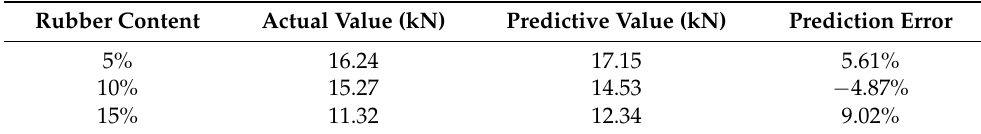
Table 7. Duration (4) single-parameter neural network prediction results.